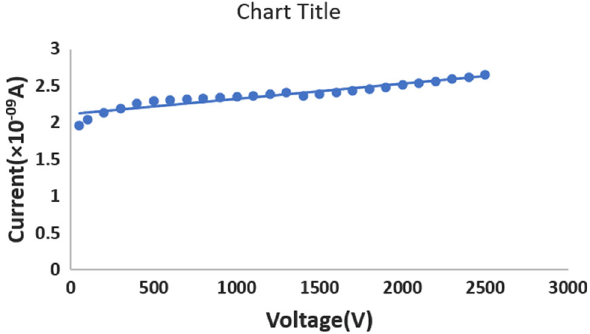
Fig. 5 The surface leakage current ( I ) versus voltage ( V ) for USD- W03 at 95K. The reciprocal of the slope of this line gives the resistance at 95K